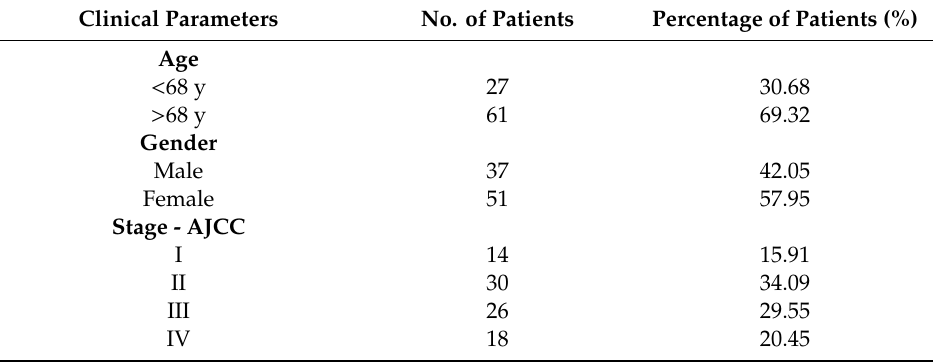
Table 2. Demographic and clinical information of colorectal cancer patients included in this study. Clinical